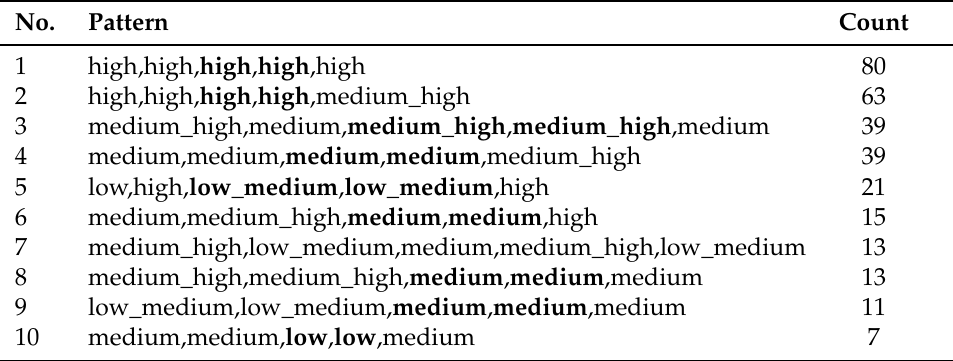
Table 7. Top 10 weekly patterns detected as outliers in 2017 and 2018 in total.